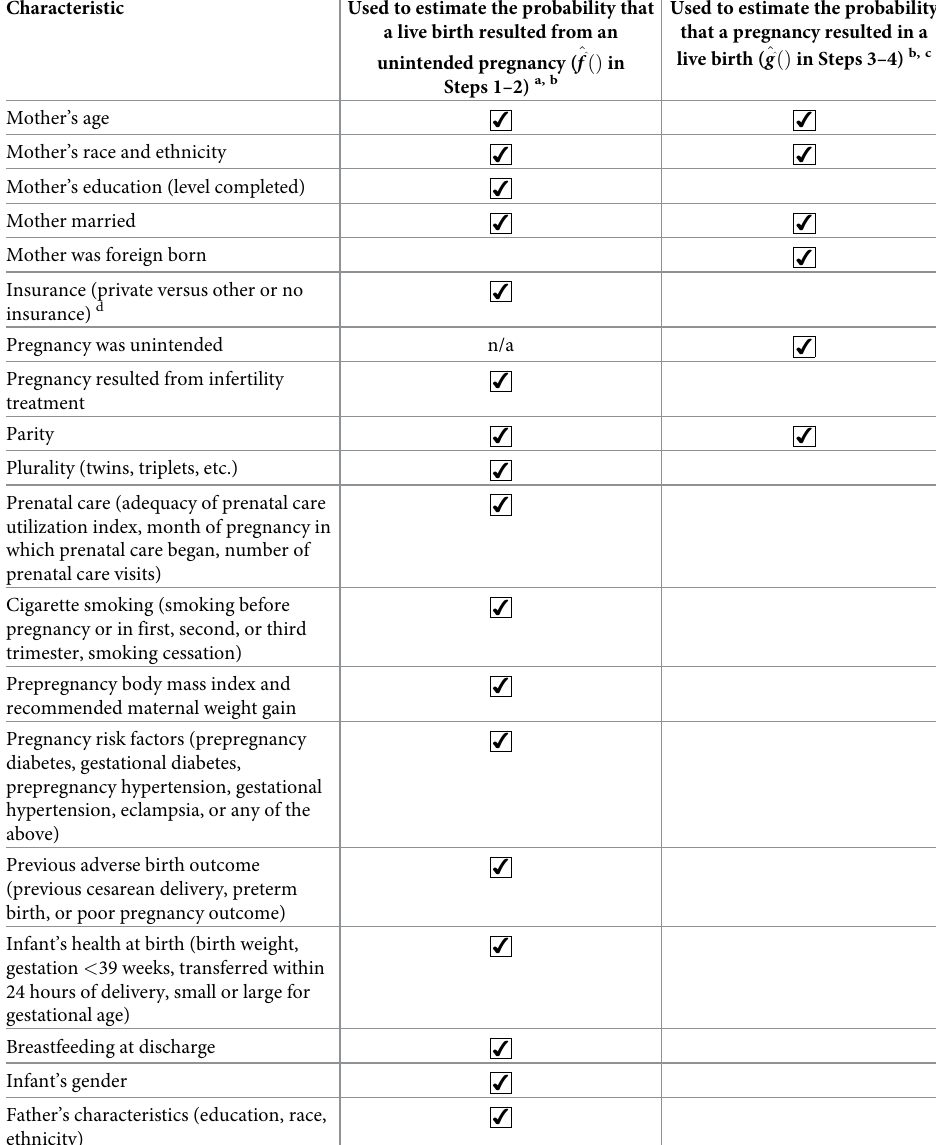
Table 2. Demographics and other characteristics included in the predictive